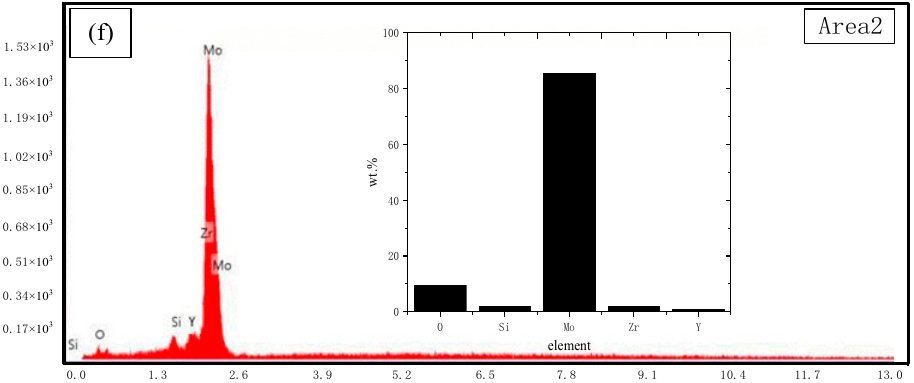
Figure 4. Mo–3Si–1B–1Zr–1Y 2 O 3 alloy fracture characteristics ( a ) fracture surface; ( b ) partial enlargement of the crystalline fracture; ( c ) partial enlargement of the transgranular fracture; ( d ) intergranular fracture zone; ( e , f ) the EDS spectrum on the fracture surface.